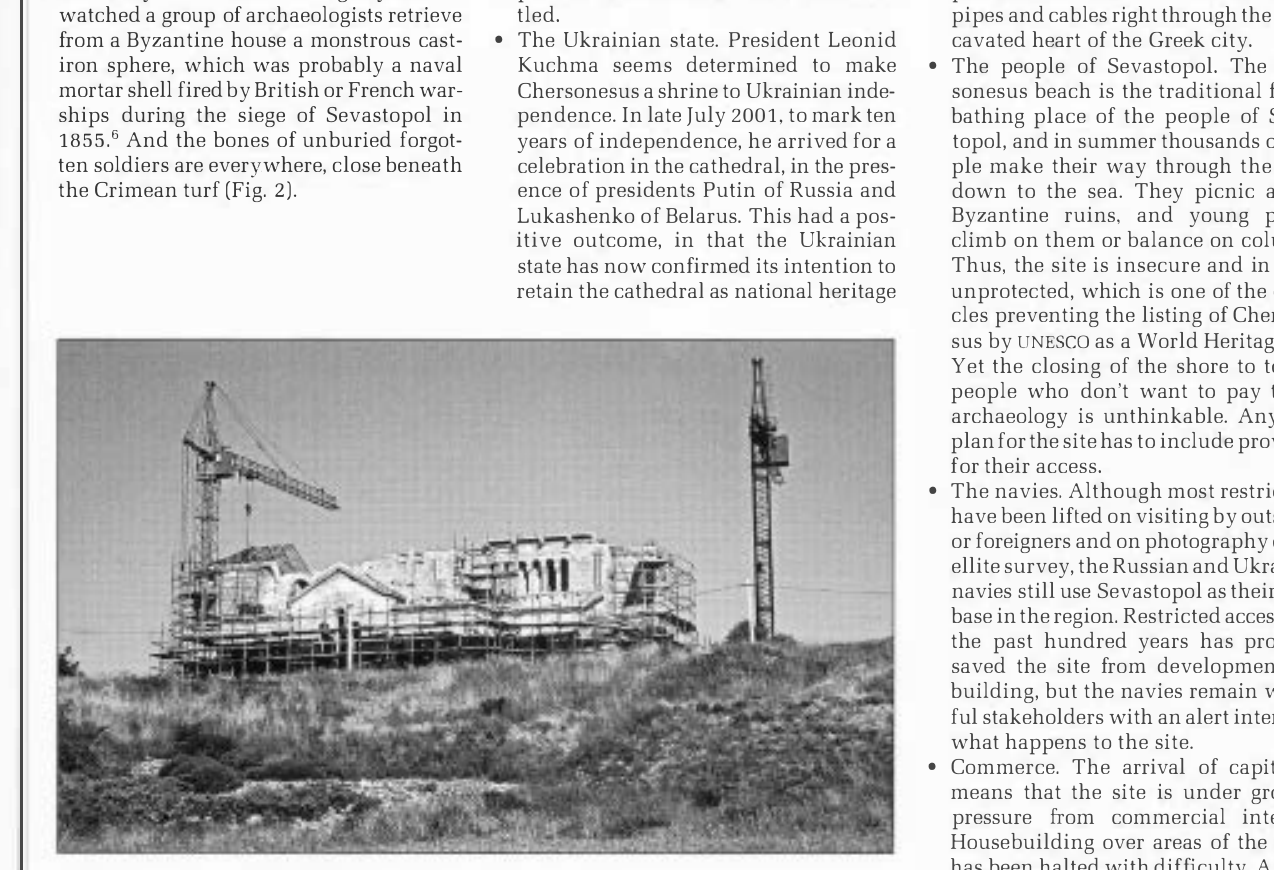
Figure 3 The ruined nineteenth-century cathedral of St Vlodymyr on the acropolis of Chersonesus under reconstruction, June 2000.